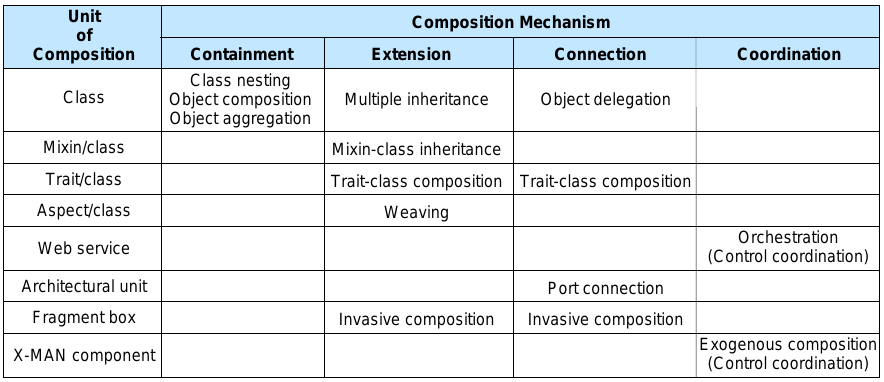
Figure 3. A taxonomy of software composition